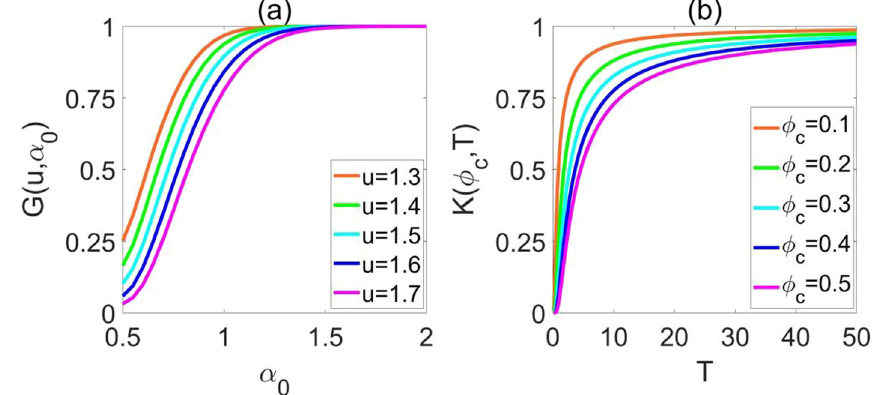
Fig. 33 The left figure represents the total probability of the universe with a scale factor a ≥ u , where the horizontal axis is the parameter α 0 and the vertical axis represents the total probability of the universe with a ≥ u . The parameters are fixed as p a = 1 and V 0 = 50. The right